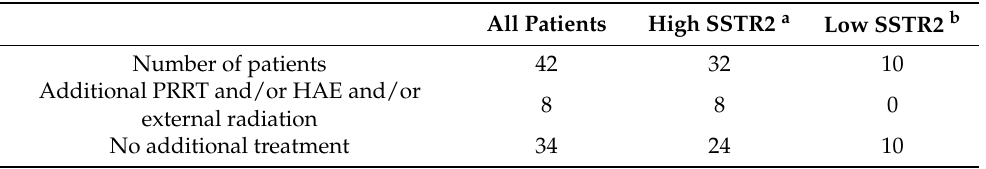
Table 2. Additional treatment after PRRT. None of the patients with low SSTR2 expression re- ceived further treatment except somatostatin analogues (SSA), after PRRT. HAE = hepatic artery embolization.